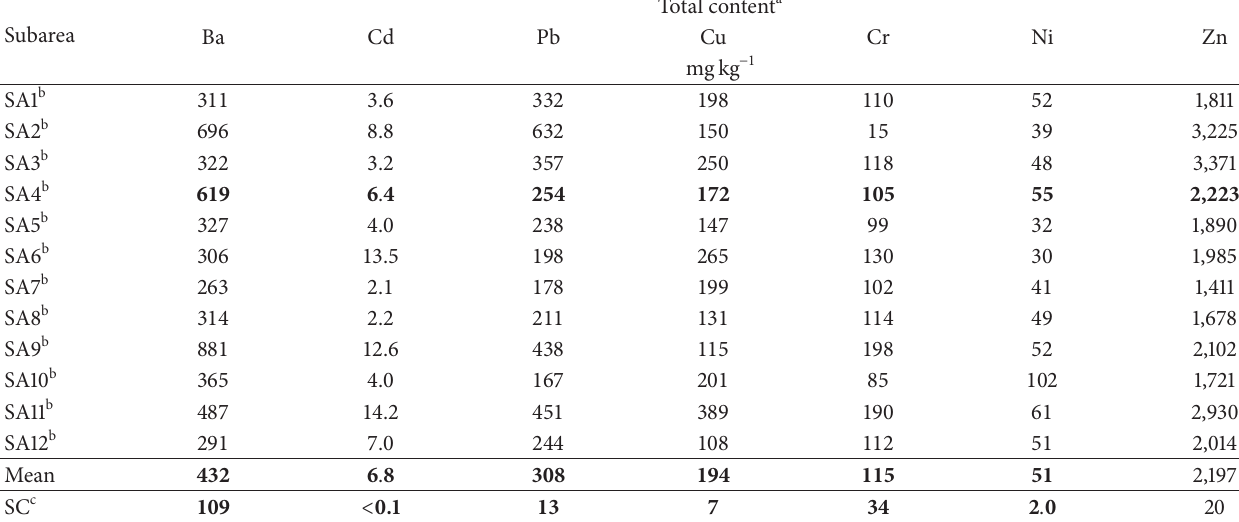
Table 1: Heavy metal concentrations of the twelve subareas